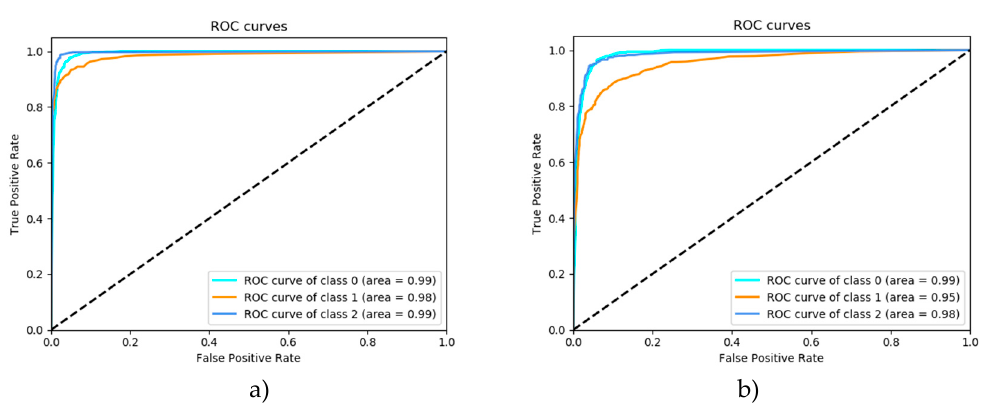
Figure 5. Receiving Operator Characteristics (ROC) curves, per class: ( a ) multispectral data; ( b ) hyperspectral data. Color code: class 0 (dark blue) = “healthy”, class 1 (orange) = “suspicious”, class 2 (blue) = “infected”.